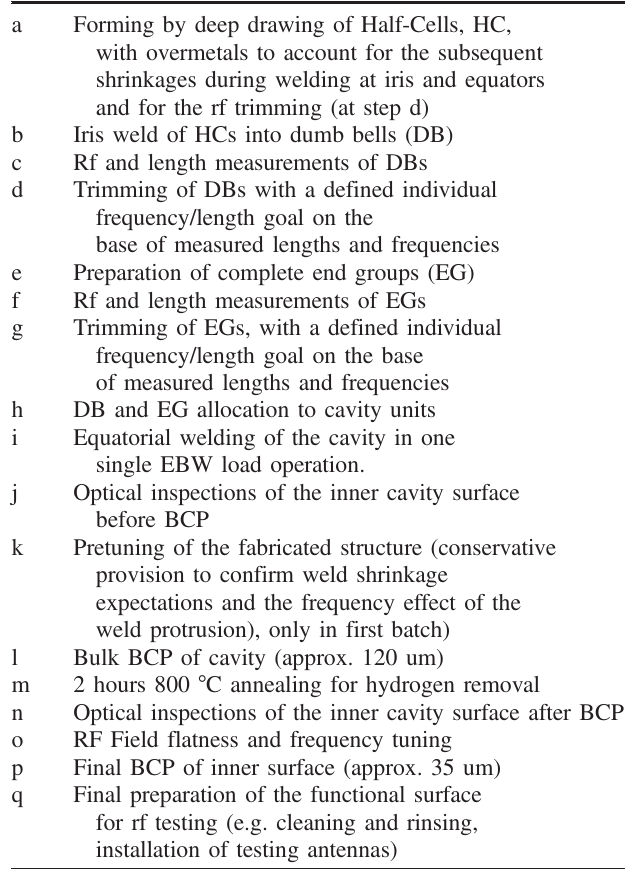
TABLE III. Main cavity preparation